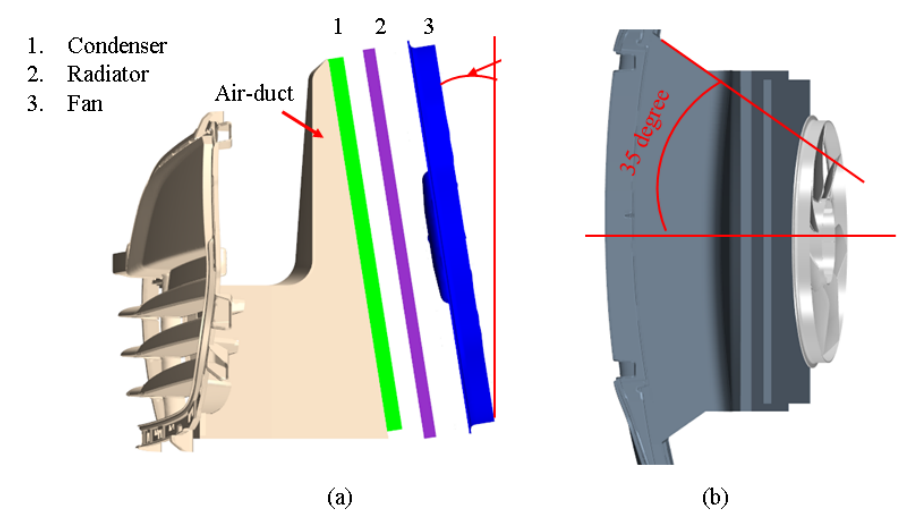
Figure 2. Inclined Condenser, Radiator, and Fan Module (CRFM) and air-duct in Case 2; ( a ) side view, ( b ) top view.